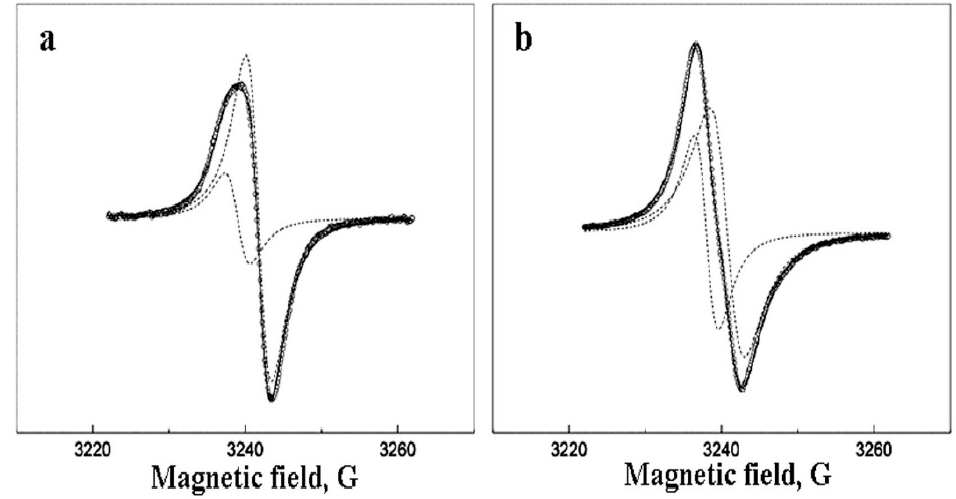
Figure 6. The numerical decomposition of the EPR spectra for the sample with 10 wt.% Pd at 1 mW ( a ) and 100 mW ( b ). The circles are experimental points, the dotted lines are Lorentzian components, solid line is the sum of these Lorenzians.